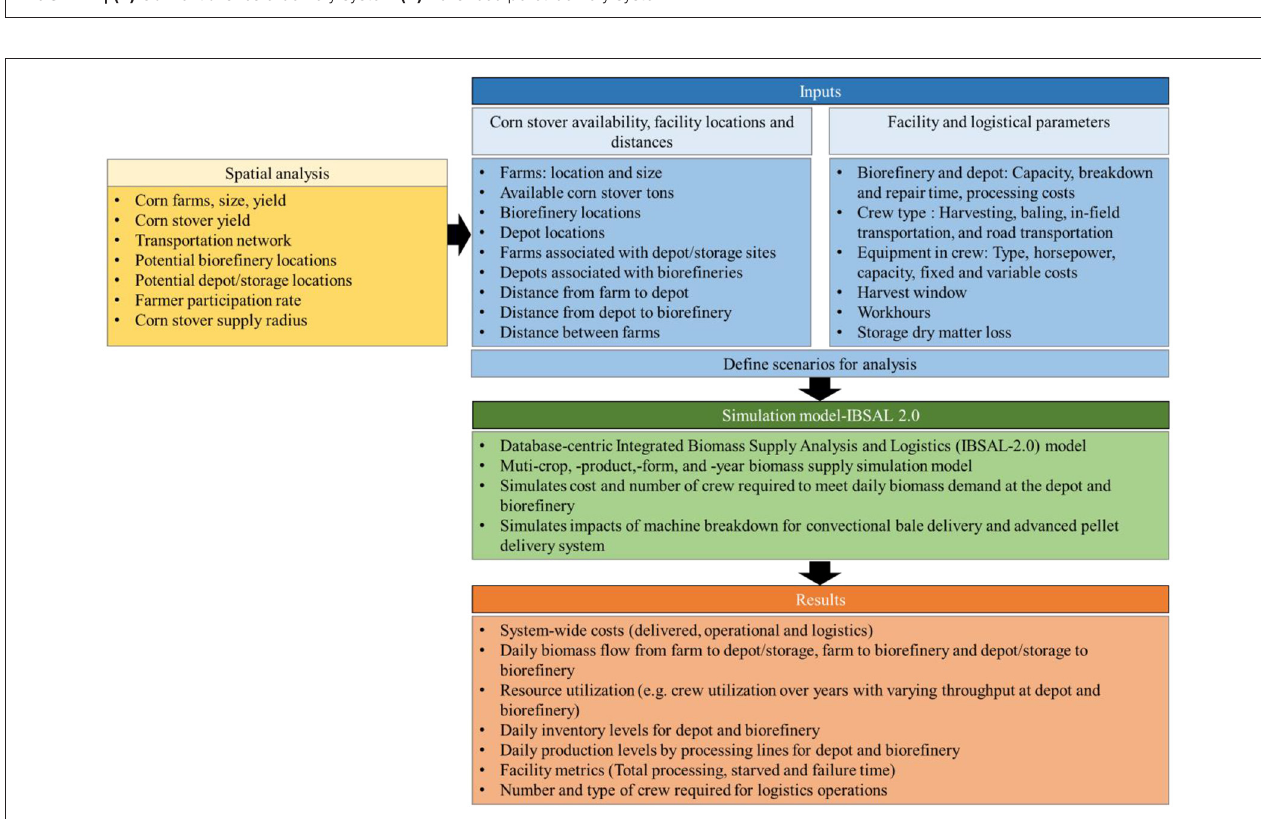
FIGURE 2 | Schematic of the methodology used to quantify the impact of operational disruptions on costs, biomass flow, resource utilization, inventory and facility metrics for the conventional bale-delivery and advanced pellet-delivery system